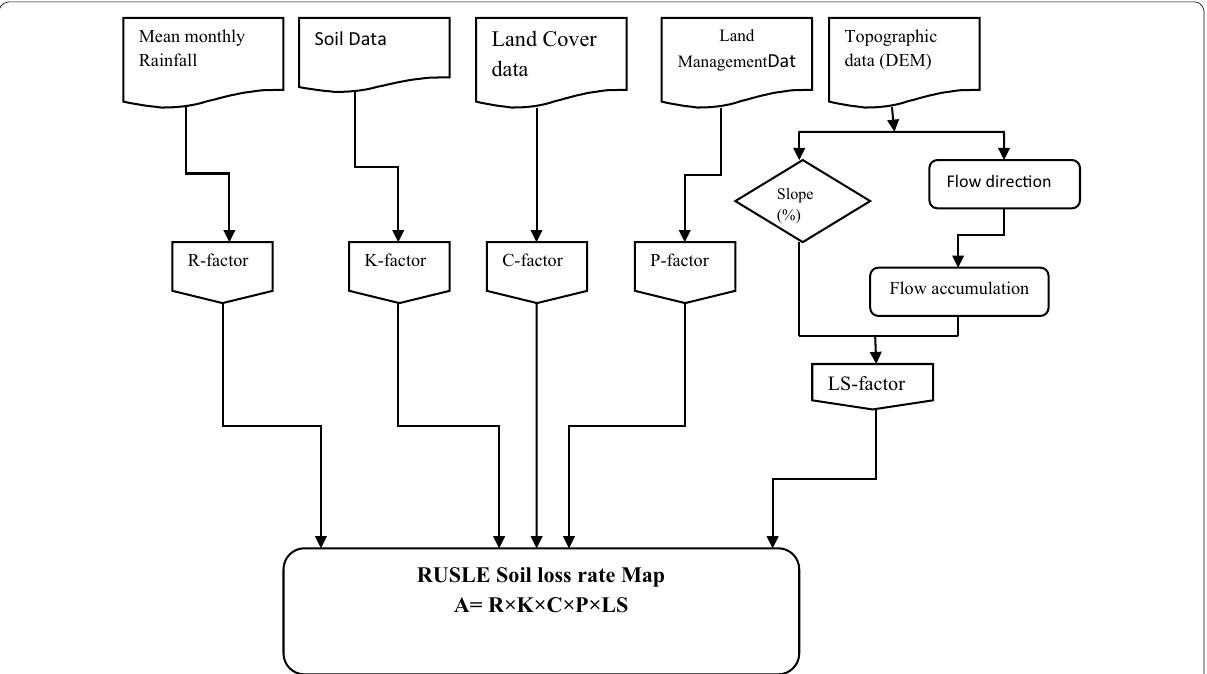
Fig. 4 Flow chart showing the factors of RUSLE model to analyze the potential soil loss of the study catchment with the application of GIS